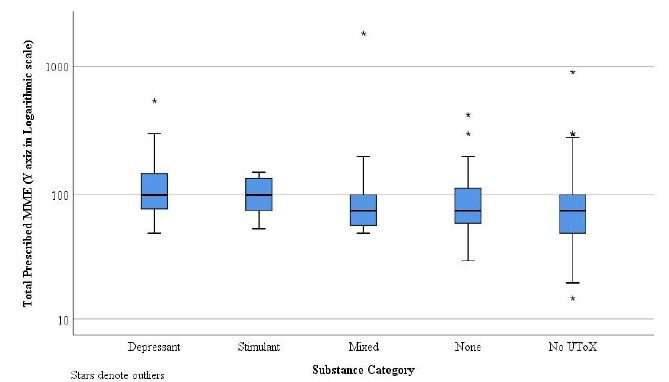
Figure 2. The median total morphine milligram equivalents across drug classes.